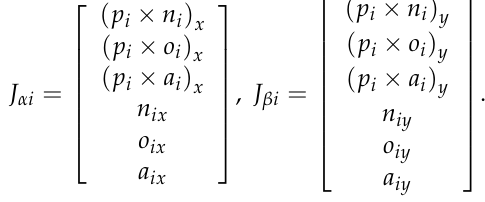
where J α ( q ) , J β ( q ) ∈ R 6 × n represents the Jacobian matrix that maps the bending defor- mation of the joint space to the operation space, which can be abbreviated as J α and J β , respectively. The joins of the manipulator in this paper are all rotating joints, hence, the i -th column of J α and J β can be expressed